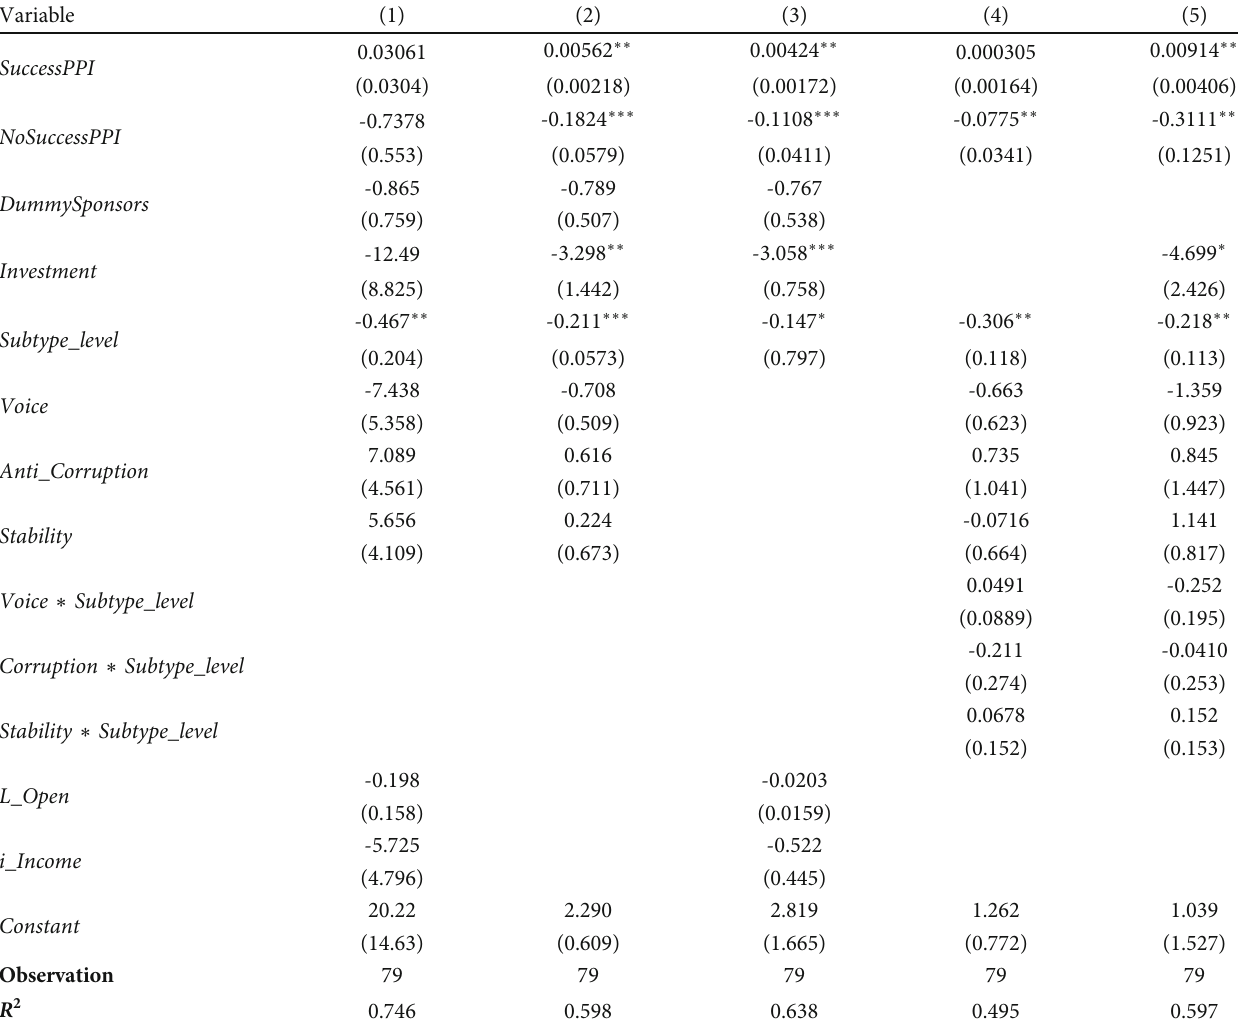
Table 8: Results of regression model 1: factors determining the success or failure of a Green PPP